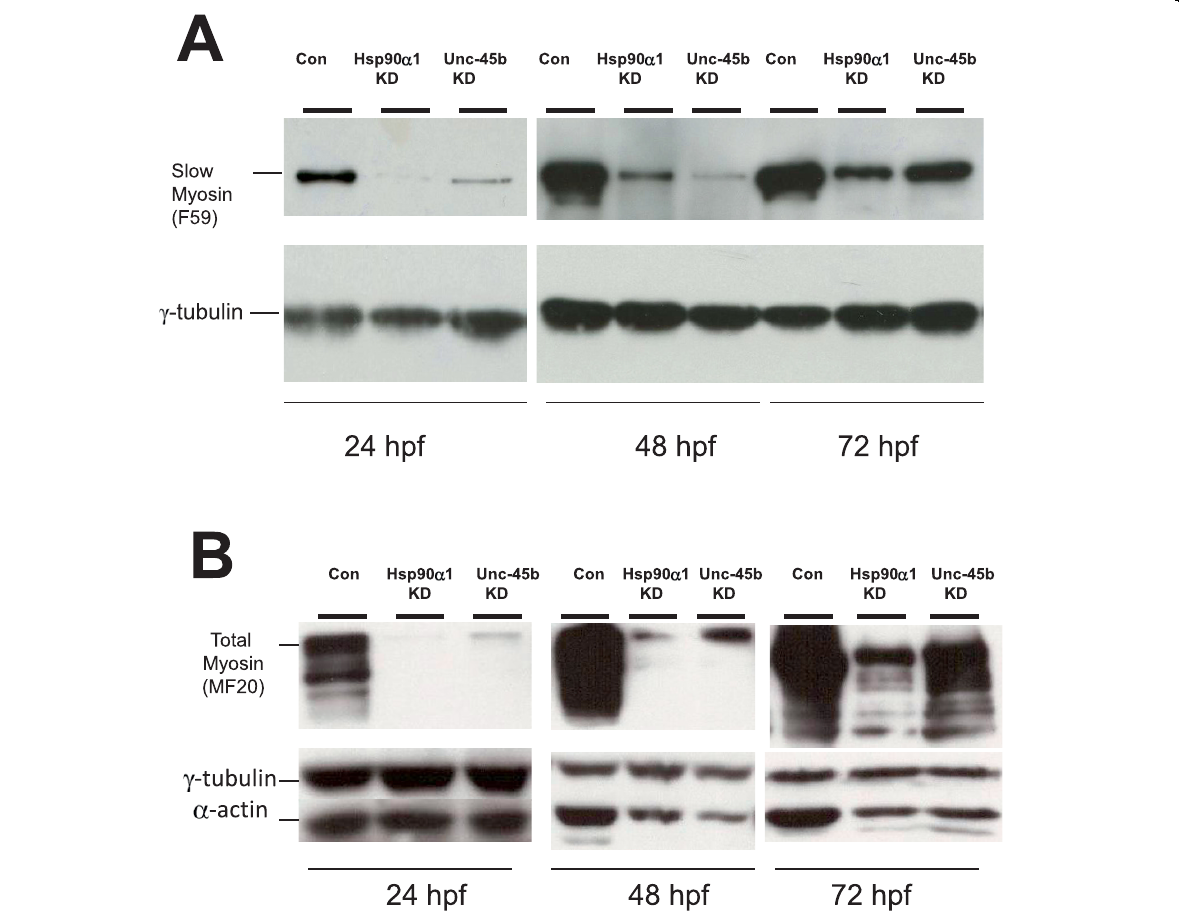
Figure 2 Knockdown of Unc-45b or Hsp90 a 1 results in significant reduction of myosin and a -actin accumulation . Western blot was performed using protein extracts from Unc-45b or Hsp90 a 1 knockdown, or uninjected control embryos at 24, 48 and 72 hpf using anti-myosin antibodies F59 (A) and MF20 (B) that recognize slow muscle myosin or general myosin proteins, respectively. The data show decreased levels of slow or total myosin proteins in Unc-45b and Hsp90 a 1 knockdown embryos at 24 and 48 hpf. A partial recovery of myosin expression was noted in 72 hpf embryos. Decreased levels of a -actin were also detected in the Unc-45b and Hsp90 a 1 knockdown embryos at 48 and 72 hpf. g -tublin was used as loading control. Protein extract from five embryos each was used at 24 hpf. Protein extracts from three embryos were used at 48 and 72